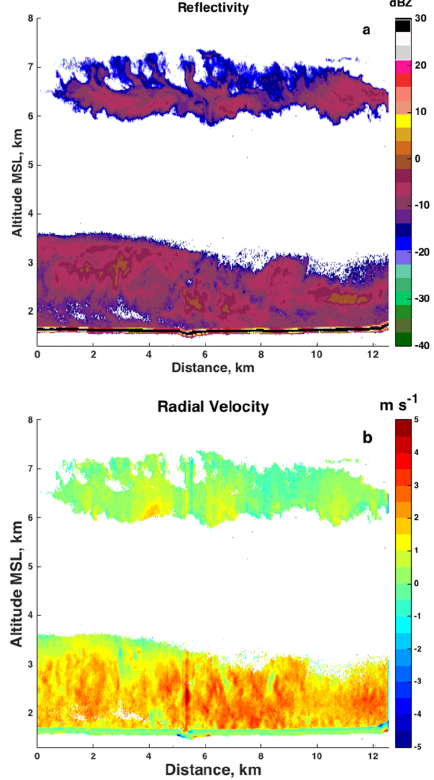
Figure 11. B-scan plots of Ze and V r collected on 23 February 2013 from the HCR looking